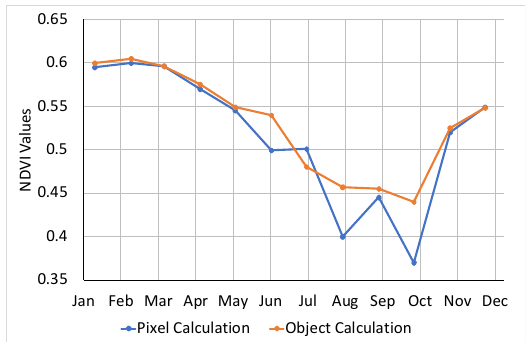
Figure 11. Comparison between computation spectral indices using a pixel and object approach.